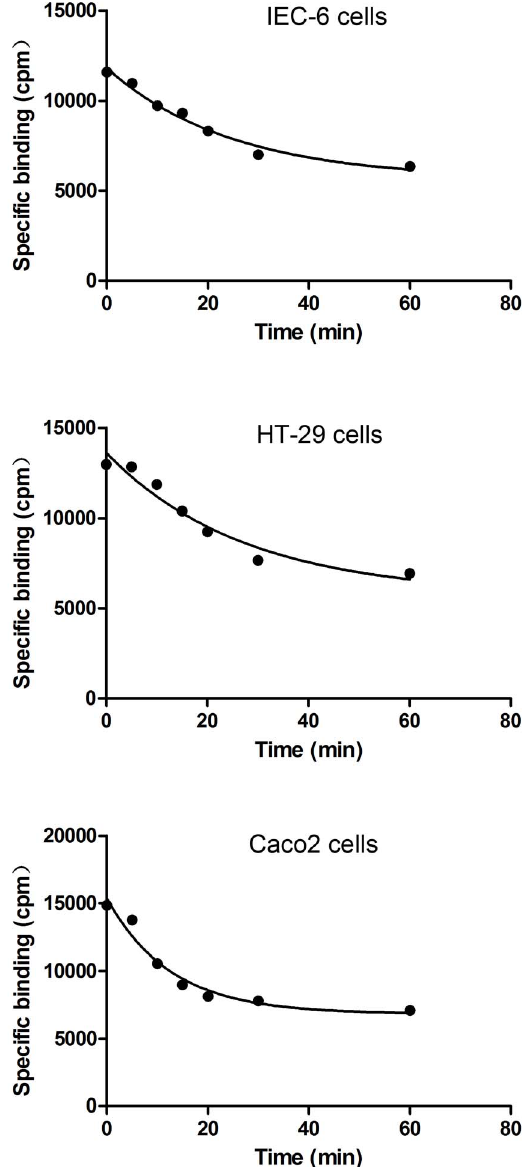
Figure 4. Dissociation of ITF from epithelial cells.